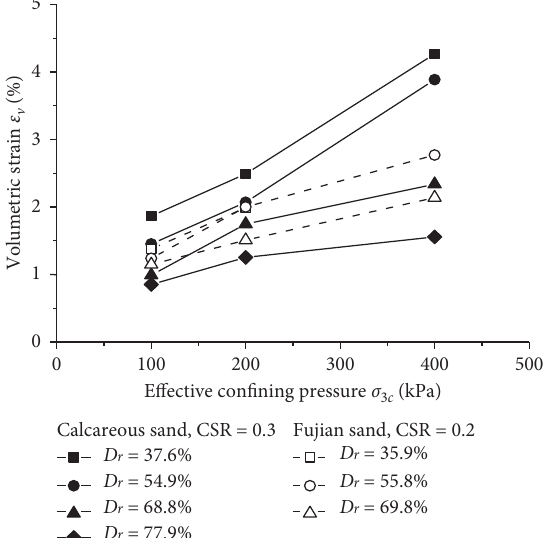
Figure 18: ε V ∼ σ 3c curve of calcareous sand and Fujian sand.